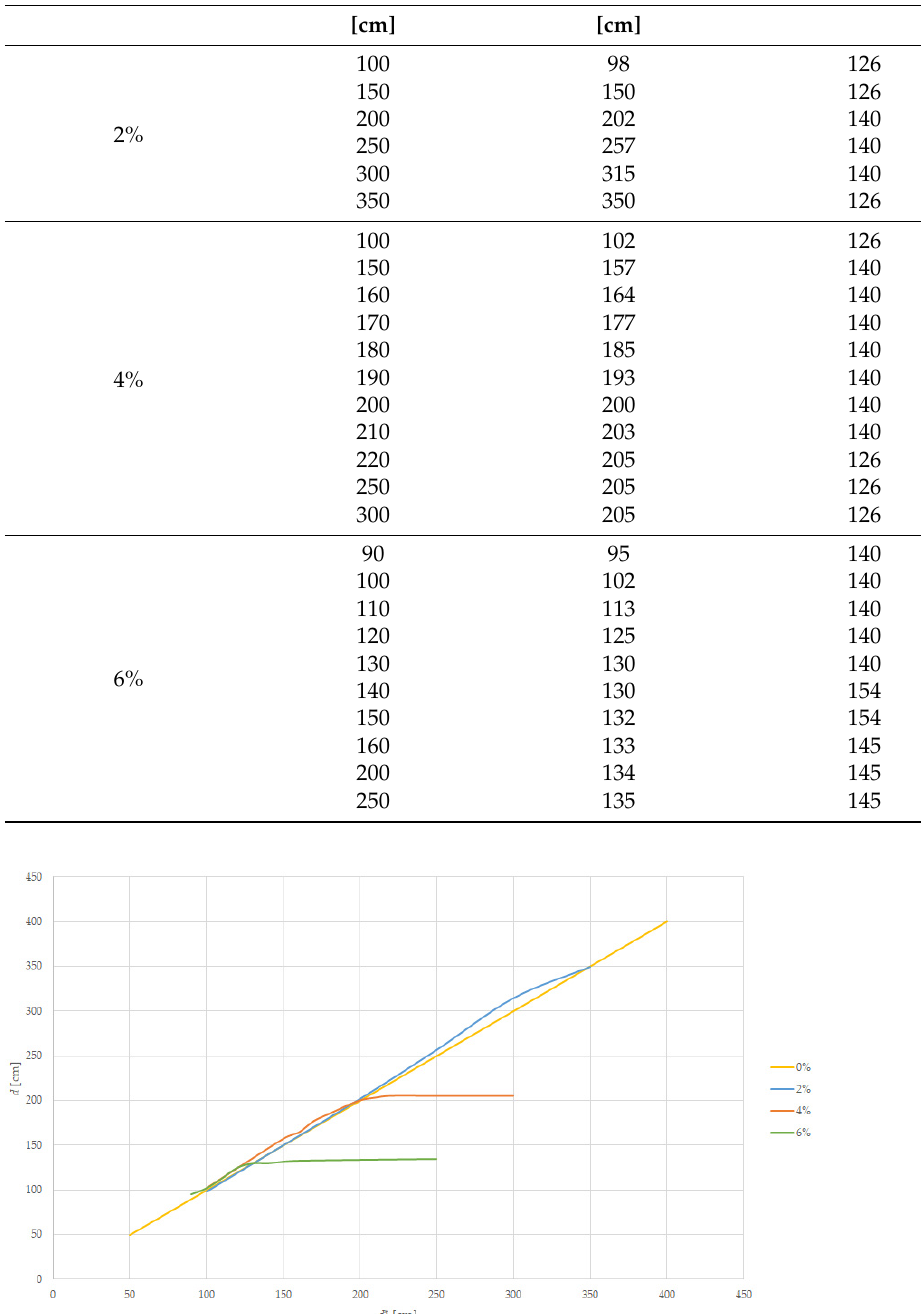
Table 6. Uphill vertical track experimental results with car target on track.